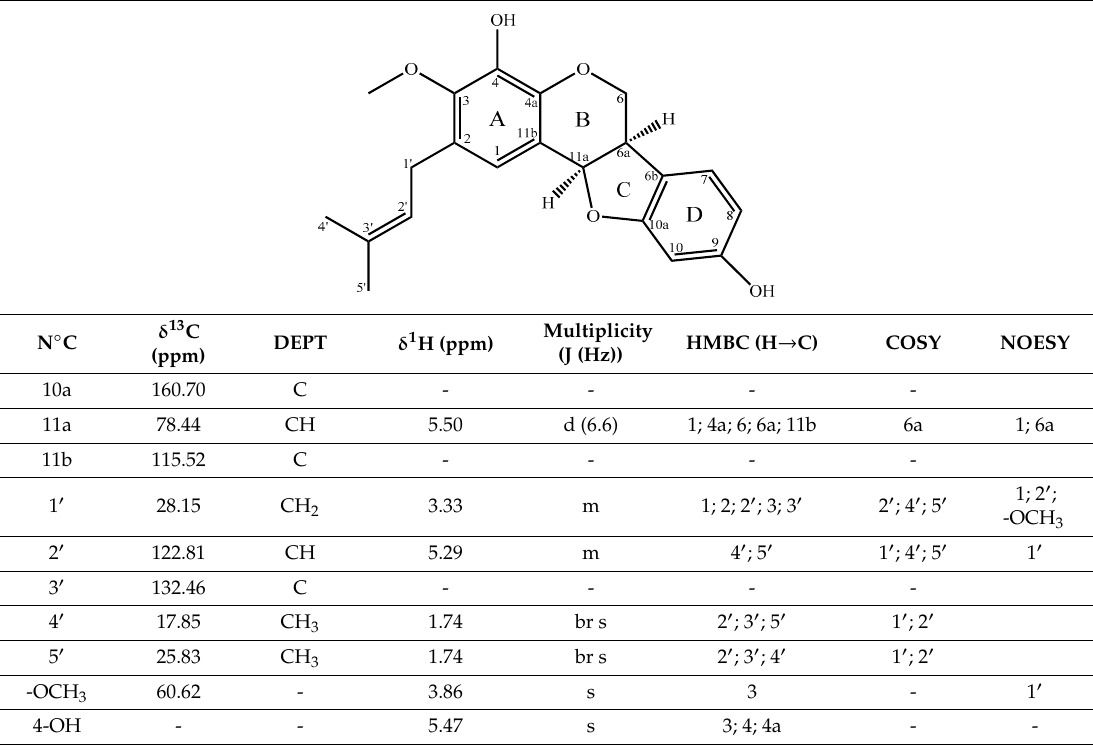
Table 2. Cont. Table 2. Structure (relative stereochemistry) and NMR data of compound 2